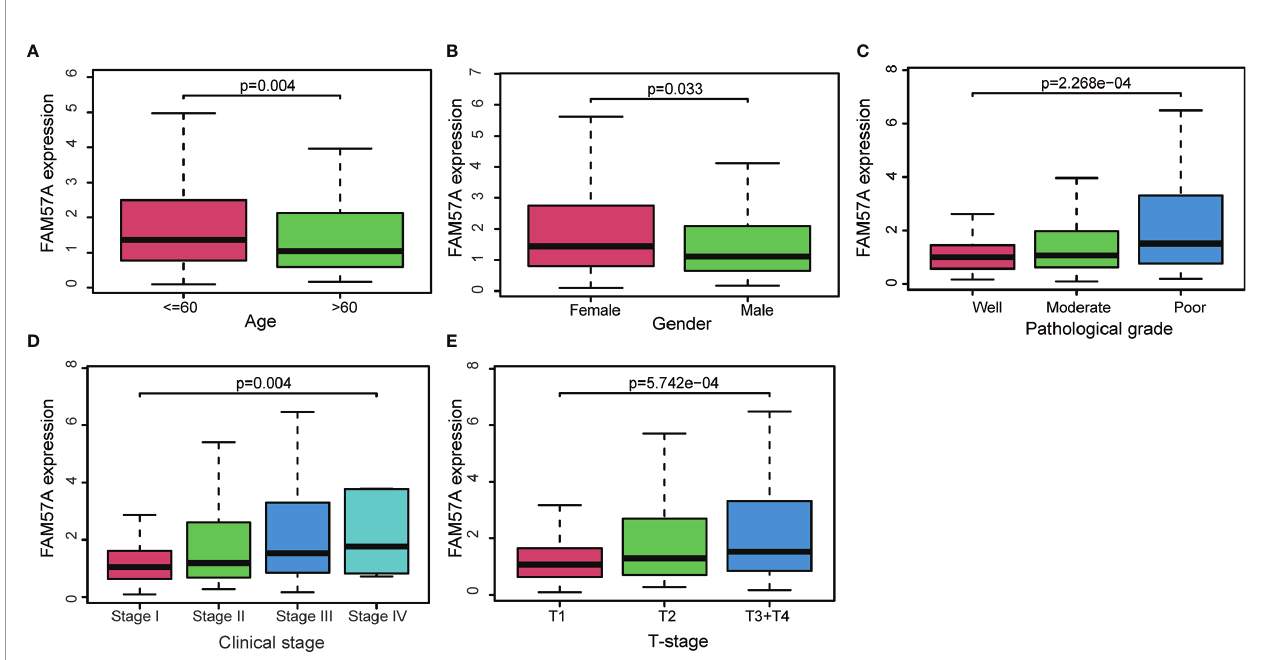
FIGURE 4 | Association with FAM57A expression and clinicopathologic characteristics. (A) Age. (B) Gender. (C) Pathological grade. (D) Clinical stage. (E) T